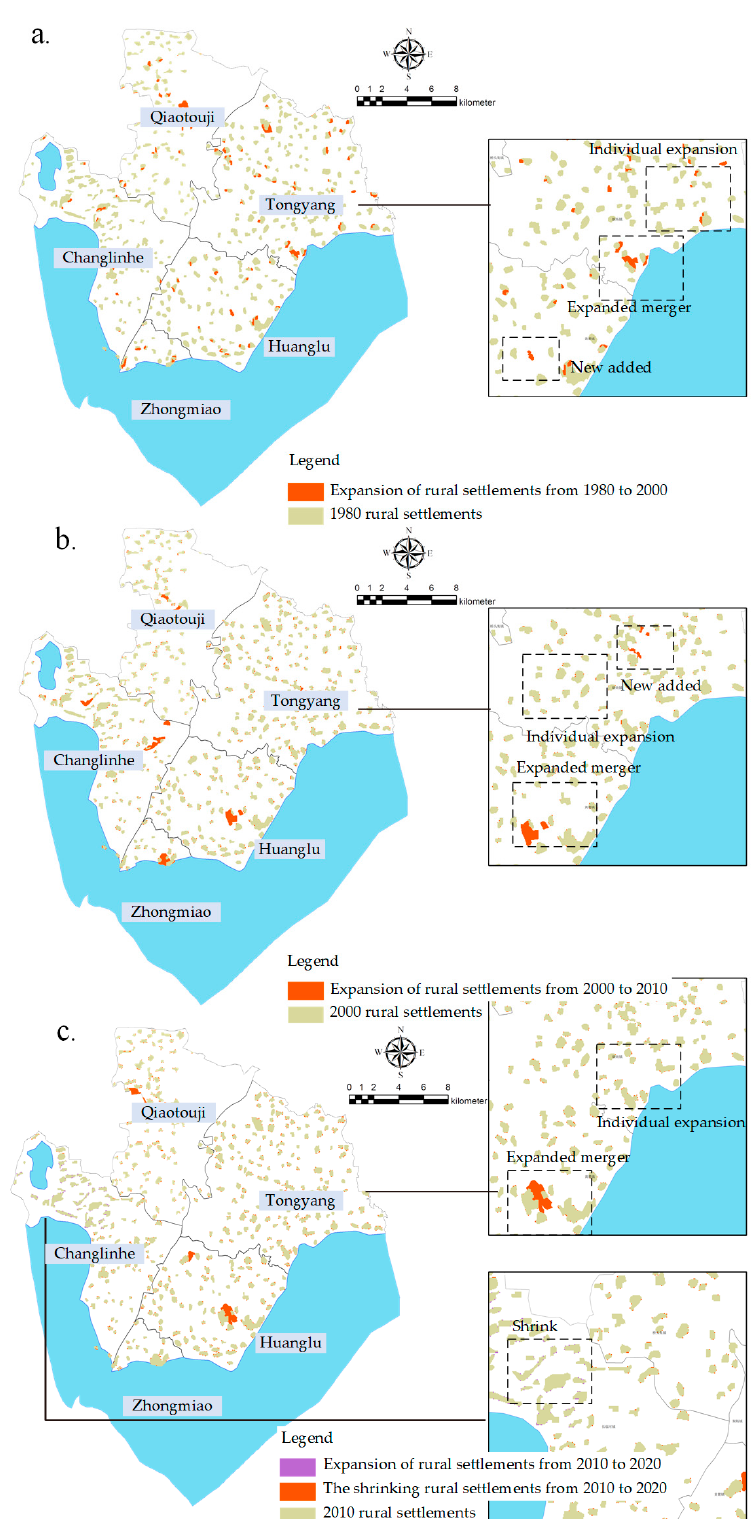
Figure 6. The evolution model of rural settlements in the suburbs of Hefei from 1980 to 2020. ( a ) Change pattern of residential areas in the study area from 1980 to 2000, ( b ) Change pattern of residential areas in the study area from 2000 to 2010, ( c ) Change pattern of residential areas in the study area from 2010 to